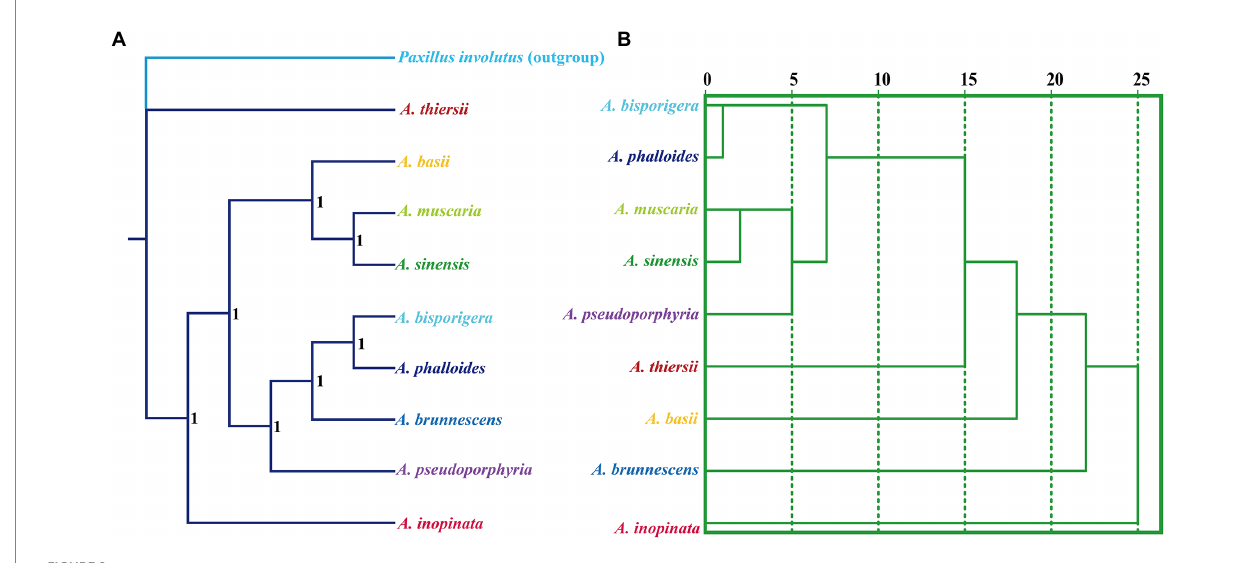
FIGURE 9 Relationship inference of different Amanita species based on the Bayesian inference (BI) (A) method and relative synonymous codon usage (RSCU) hierarchical clustering (B) . The Bayesian posterior probabilities (BPP) value is displayed on the nodes of the